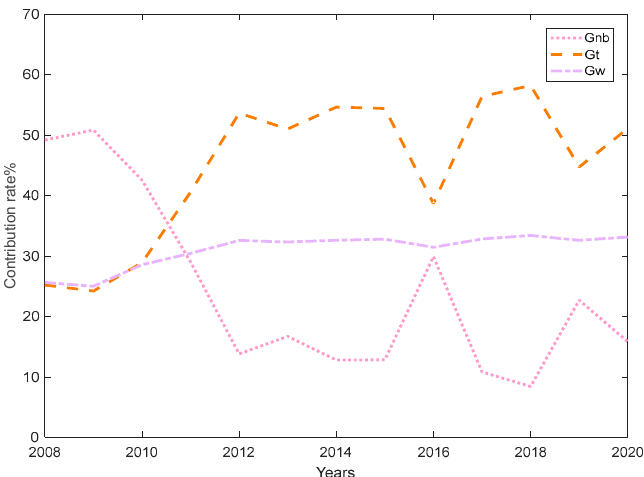
Figure 4. Differential contribution rate of ESDE from 2008 to 2020. Data source: Table 4.